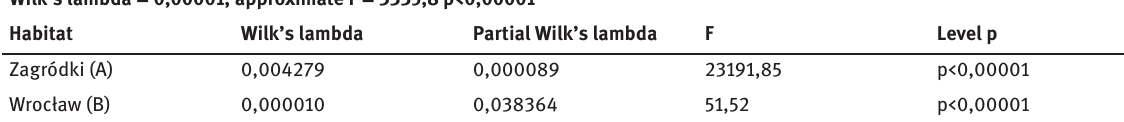
Table 4: Discriminant analysis results.